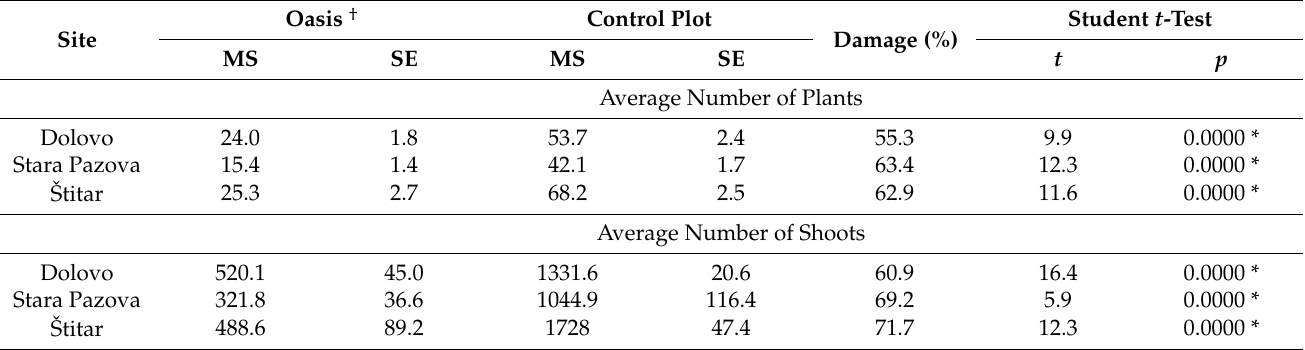
Table 1. Average number of alfalfa plants and shoots at the center of common vole colonies and in control plots.